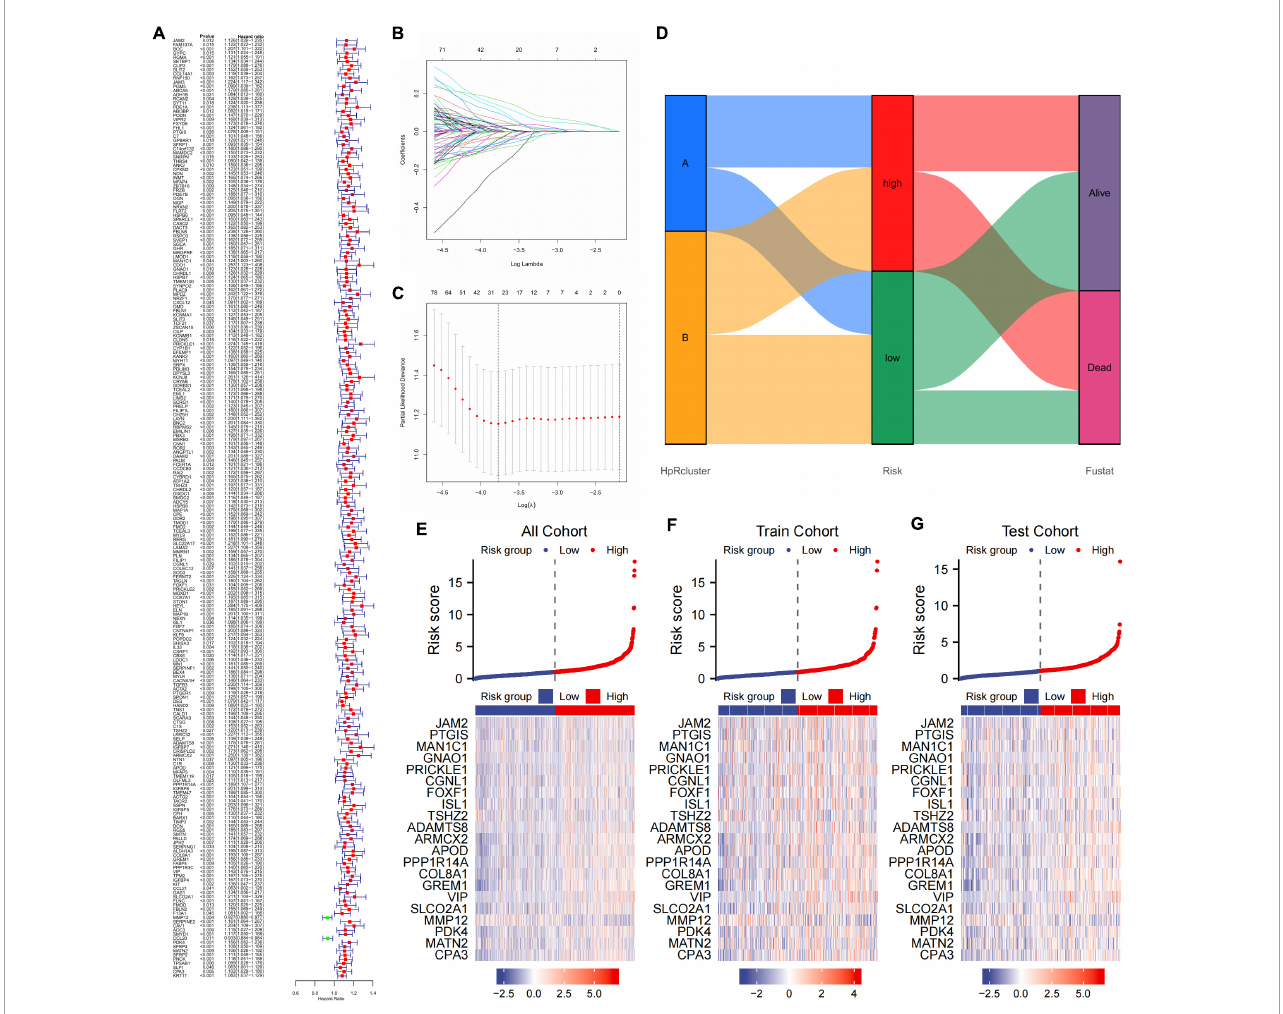
FIGURE7 Establishing a prognosis prediction model from CDEGs. (A) Univariate COX regression confirmed that HRGs significantly related to the prognosis of GC. (B,C) LASSO and multivariate Cox regression analysis. (D) Alluvial diagram of subtype distributions in groups with different risk and fustat. (E–G) Heat map showing the correlation between gene expression and risk score in all cohorts, train cohort, and test cohort. CDEGs, cancer associated fibroblast related differential expression genes; HRGs, HP-related genes; GC, gastric cancer; LASSO, least absolute shrinkage and selection